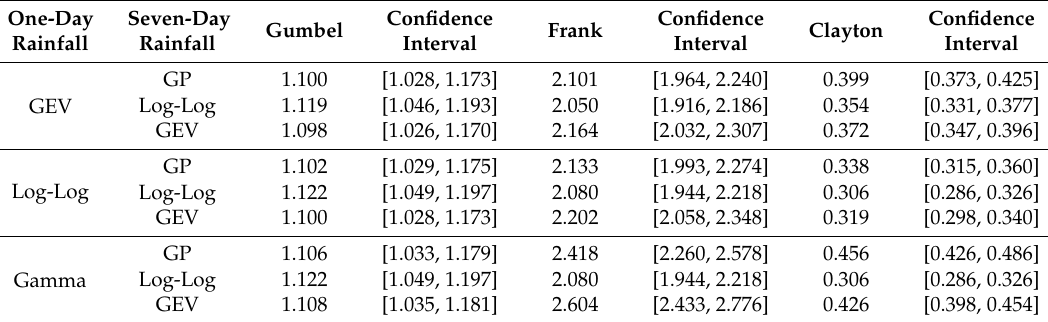
Table 5. Parameters for the copulas and their 95% confidence intervals for one-day and seven-day